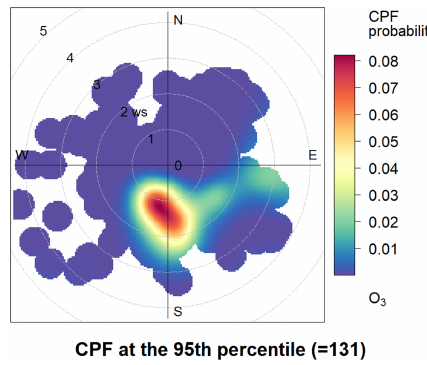
2 , RO 2 , and NO 3 in S0 (solid lines) and S1 (dashed